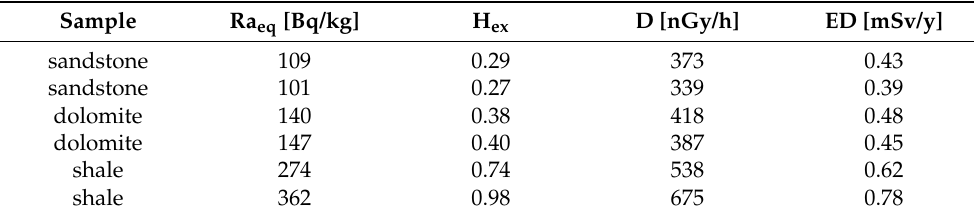
Table 5. Radium equivalent activity (Ra eq ), external hazard index (H ex ), absorbed dose rate (D) [nGy/h], and annual effective dose (ED) [mSv/y] estimated based on the 226,228 Ra and 40 K concen- trations in collected rock